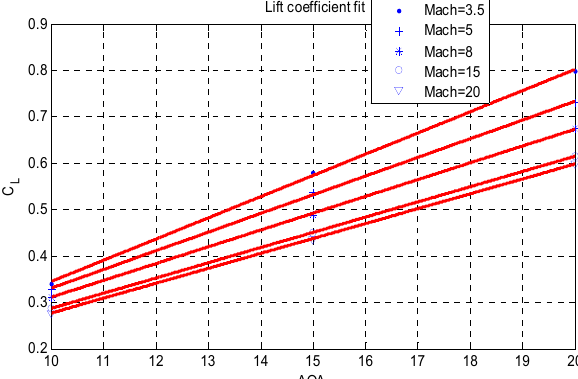
Figure A1. Polynomial fit results.